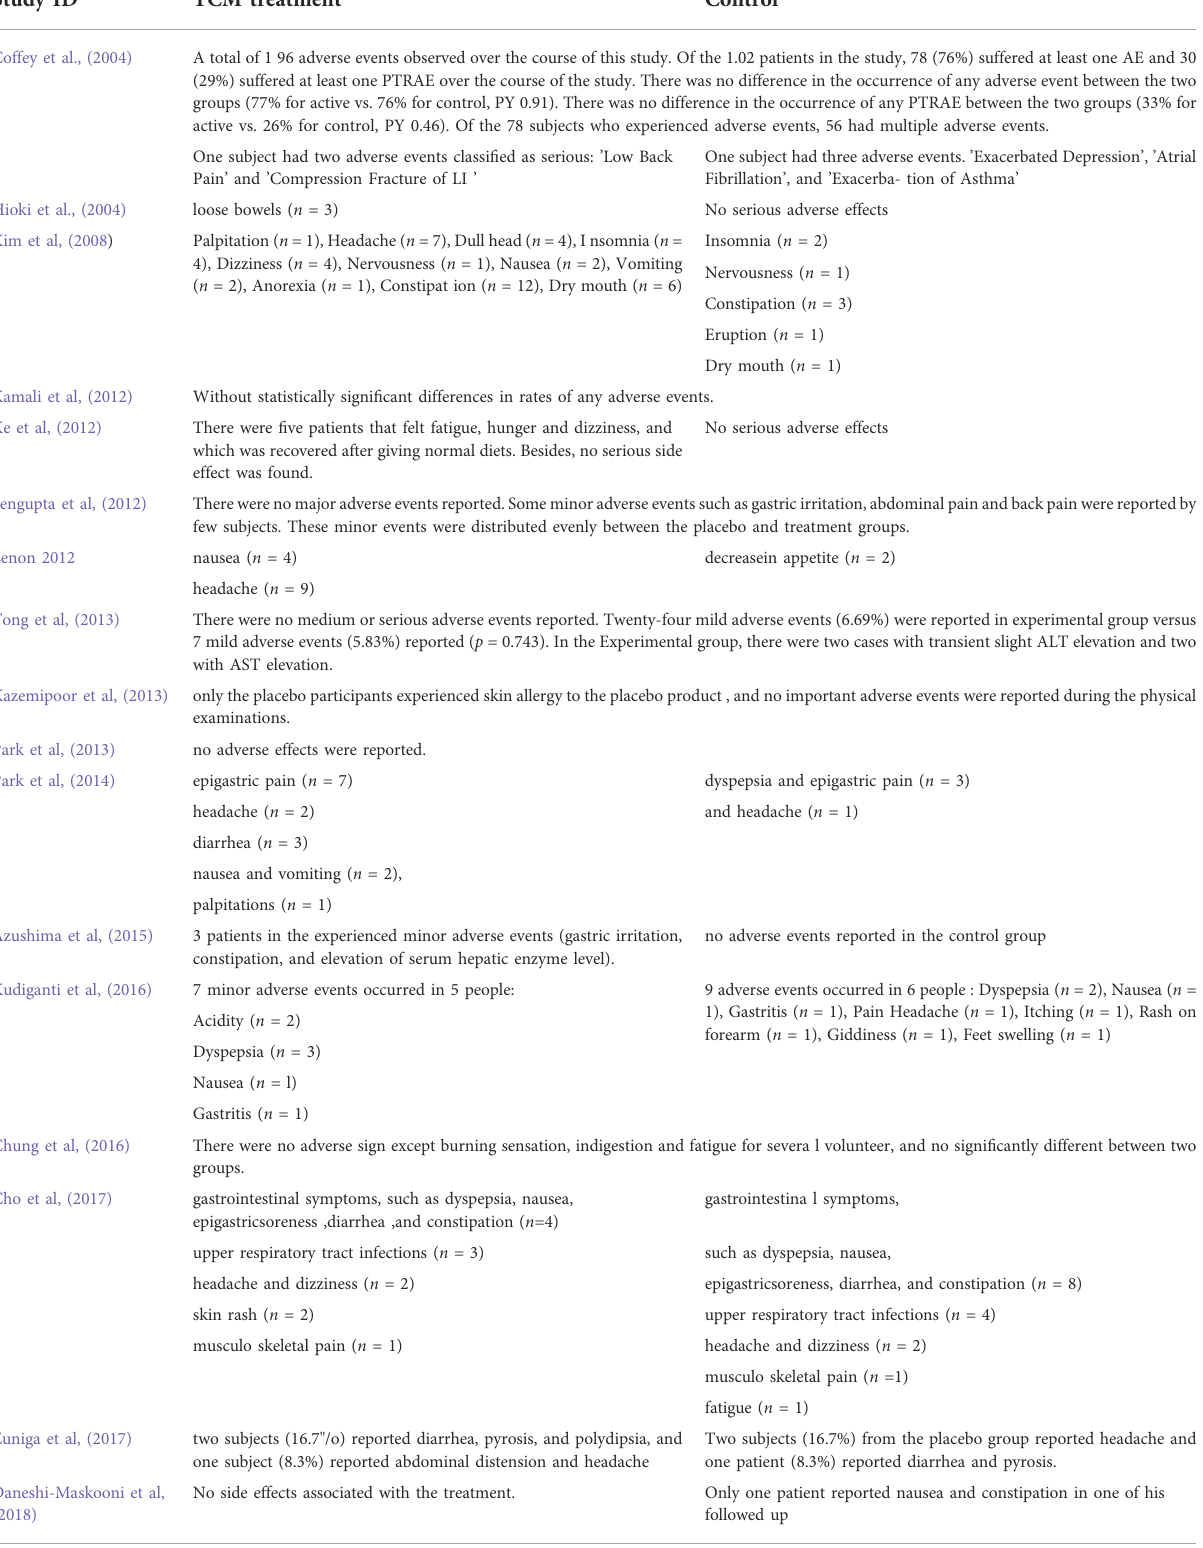
TABLE 2 Adverse reaction of included